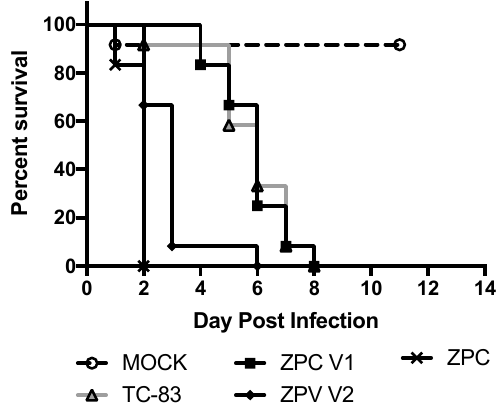
Figure 4. Survival in vaccinated mice following lethal intranasal 3908 challenge.